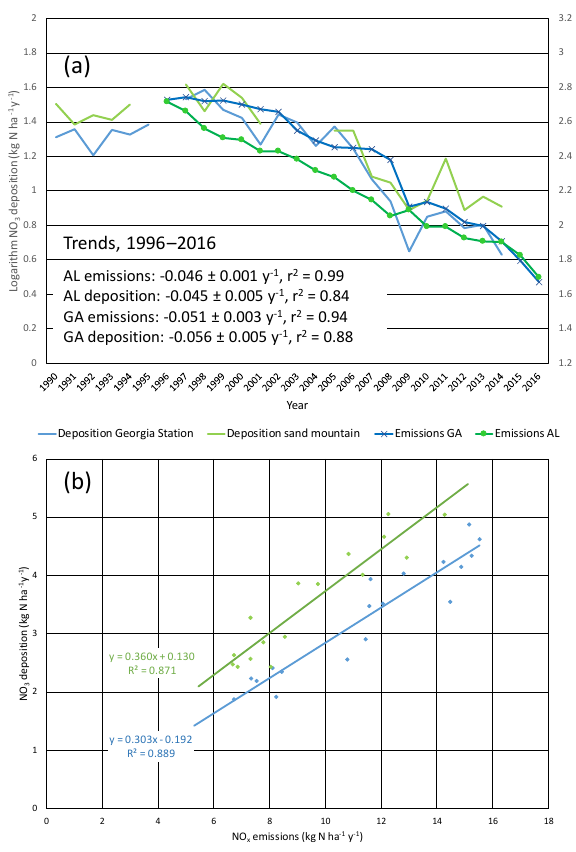
Figure 1. Comparison of nitrate deposition (wet plus dry) to NO x emission densities in Georgia and Alabama as (a) temporal trends and (b) regression of deposition against emissions (with same color coding in both panels). Nitrate deposition and NO x emission den- sities are expressed as kgha − 1 yr − 1 . NO x emissions are from all source sectors (see Supplement). Panel (a) shows natural logarithms vs. year and indicates that emissions and deposition trended down- ward at the same rates. Panel (b) slopes are statistically significant ( p < 0.0001) and intercepts are not ( p >